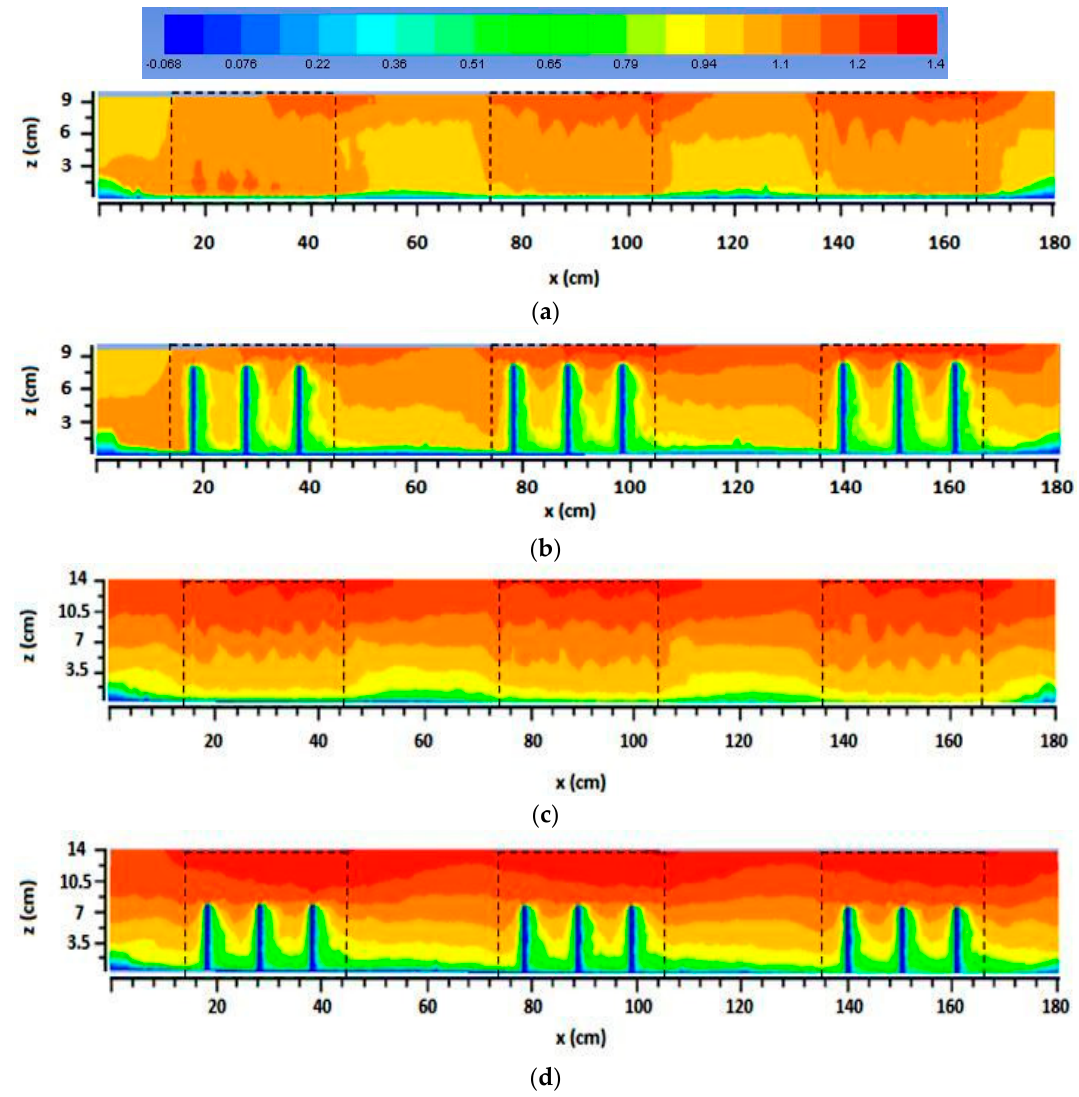
Figure 6. Contour diagrams of the mean velocity u / U for Case A at sections ( a ) y = 17.54 cm and ( b ) y = 20.08 cm; and for Case B at sections ( c ) y = 17.54 cm and ( d ) y = 20.08 cm. The dashed boxes represent the area occupied by the vegetation patches.